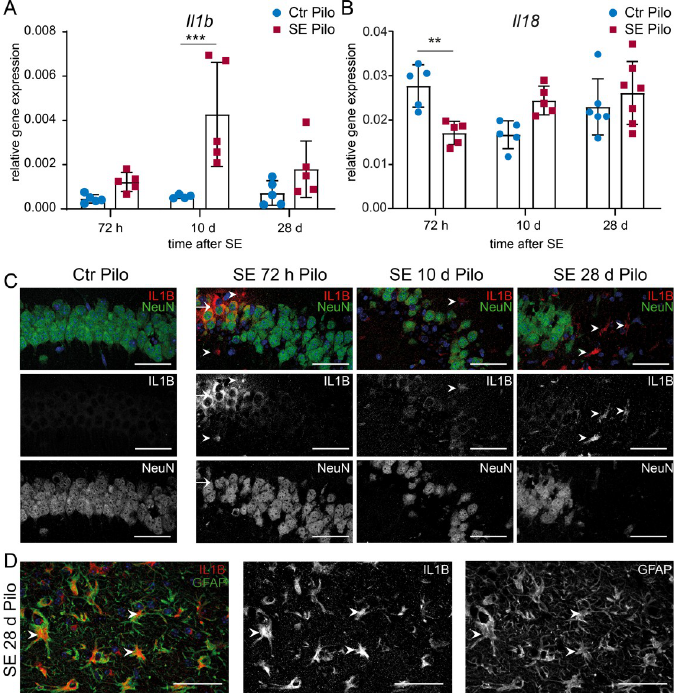
Fig 2. mRNA and protein expression levels of Interleukin 1 beta (IL1B) are transiently augmented after pilocarpine-induced SE in hippocampal CA1 region. Relative mRNA levels ( ΔΔ C t method) of ( A ) Il1b and ( B ) Il18 are analysed 72 h (n � 5), 10 d (n � 5) and 28 d (n � 6) after pilocarpine-induced SE compared to non-SE control animals (Ctr Pilo) with 2way ANOVA followed by Sidak’s post hoc test. Asterisks indicate significant differences between groups (control vs. SE): � p < 0.05, �� p < 0.01, ��� p < 0.001, ���� p < 0.0001. Detailed statistical values are found in S2 Table . The ubiquitously expressed β -actin is used as reference gene. ( C ) Representative immunohistochemistry of the hippocampal CA1 region shows 72 h after pilocarpine-induced SE a segmental expression of IL1B (red) exclusively in the CA1 pyramidal cell layer (NeuN positive neurons = green). Some non- neuronal cells are faintly IL1B positive 10 days post-SE (arrowheads). However, 28 d after SE numerous strongly IL1B positive cells are visible (arrowheads), whereas no IL1B expression is detected in non-SE control animals (leftmost, Ctrl Pilo). Scale bars: 50 μ m. ( D ) A strong co-localization with GFAP within the former pyramidal cell layer indicating IL1B positive astrocytes 28 days after SE induction. Scale bars: 50 μ m. 4 0 ,6-diamidino-2-phenylindole (DAPI) for nucleic acid counterstain